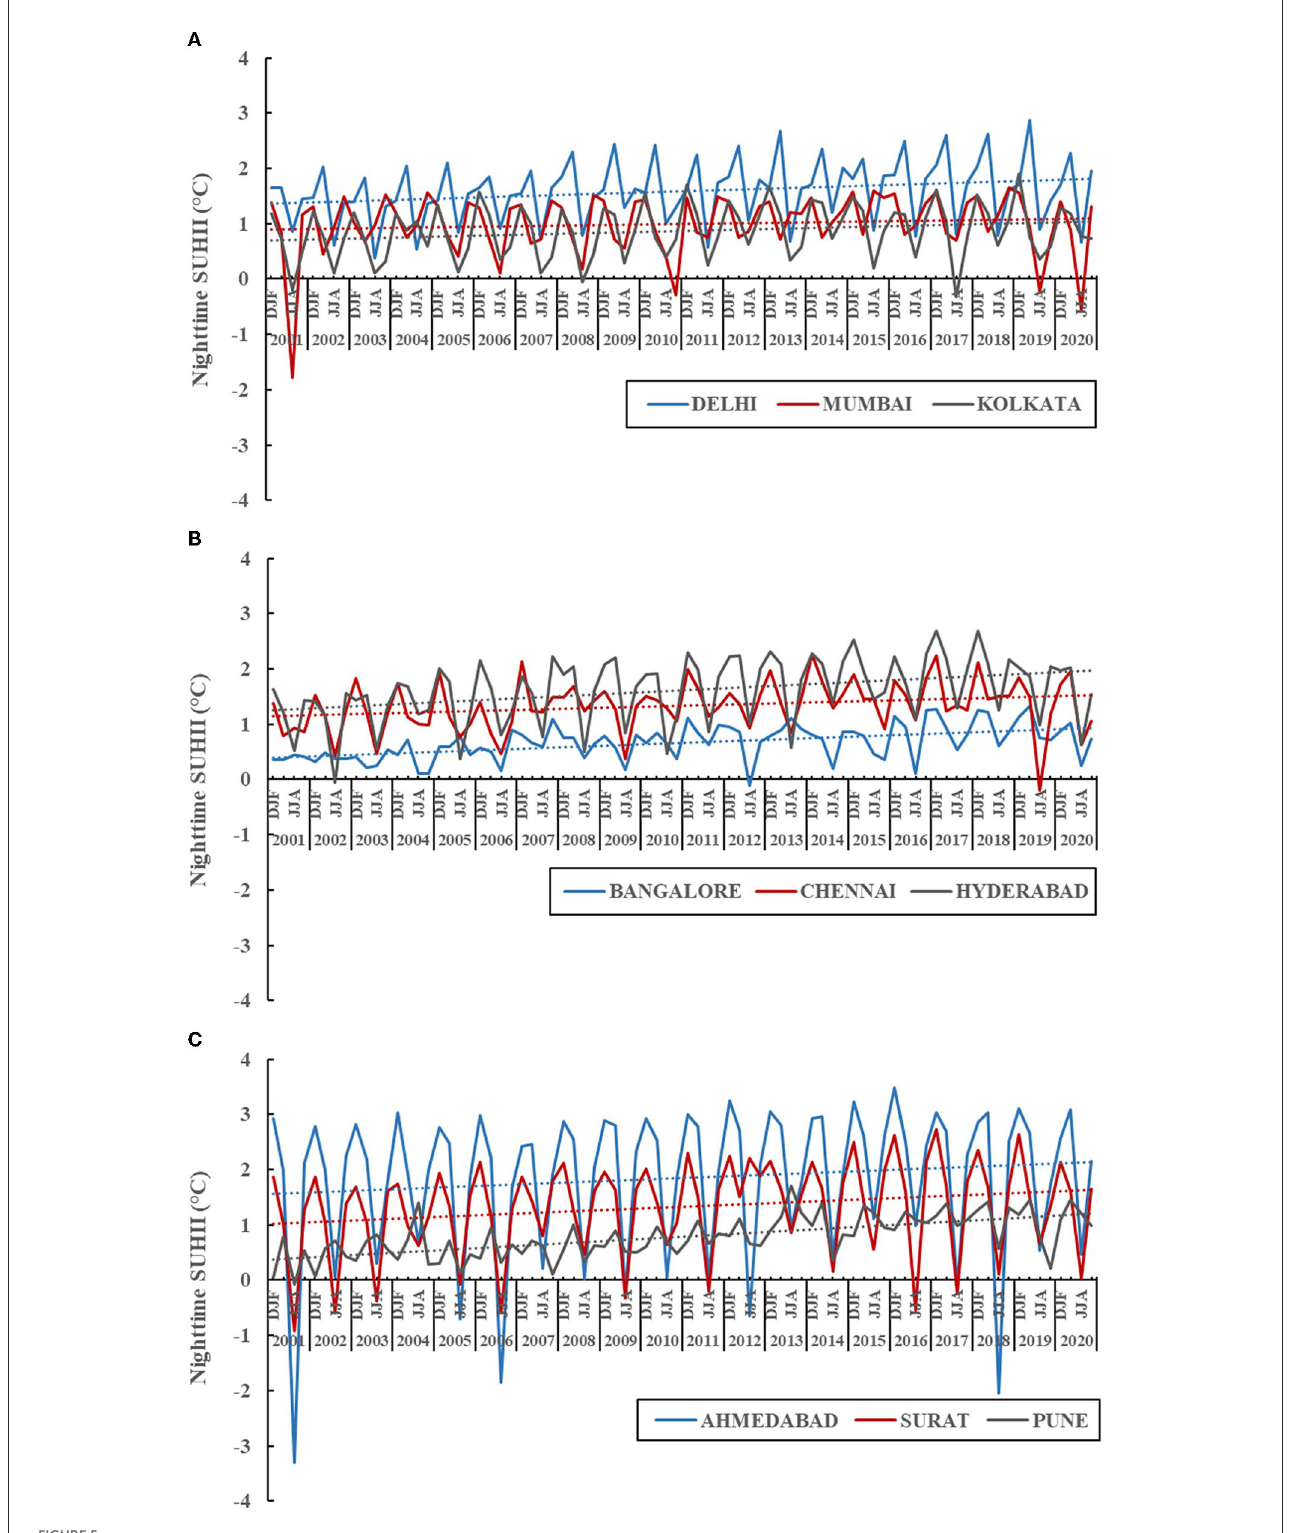
FIGURE5 A 20-year (2001–2020) mean annual nighttime surface urban heat island intensity (SUHII; ◦ C; solid lines) trend for the nine major populated cities of India (A) Delhi, Mumbai, and Kolkata, (B) Bangalore, Chennai, and Hyderabad, and (C) Ahmedabad, Surat, and Pune. Within each year the mean nighttime SUHI Intensity is estimated for DJF, MAM, JJA, and SON season. From 2001 to 2020, all cities show an increasing linear trend (dashed lines) in the mean annual nighttime